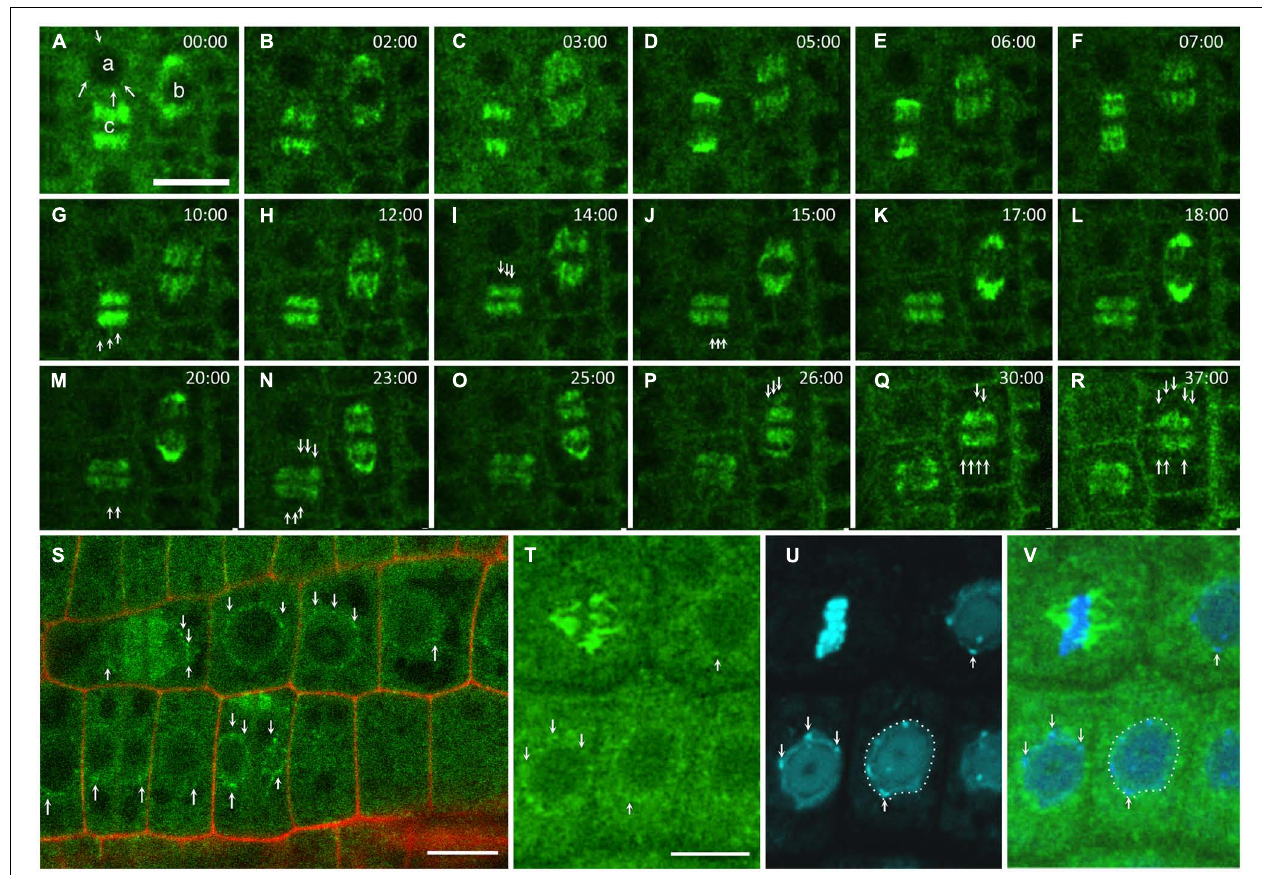
FIGURE 1 | GIP dynamics throughout the cell cycle. Time-lapse images of the expression of pGIP1::AtGIP1-GFP in an Arabidopsis root tip. Three cells were followed for 37 min, using confocal microscopy (A–R) . (A) GIP1 localizes in a dotted pattern (arrows) at the nuclear periphery of an interphase cell (a), on a prophase spindle (b) and on a metaphase spindle (c). In end-anaphase-telophase transition, GIP1 remains associated with remnant kinetochore fibers and redistributes in a dotted pattern to the